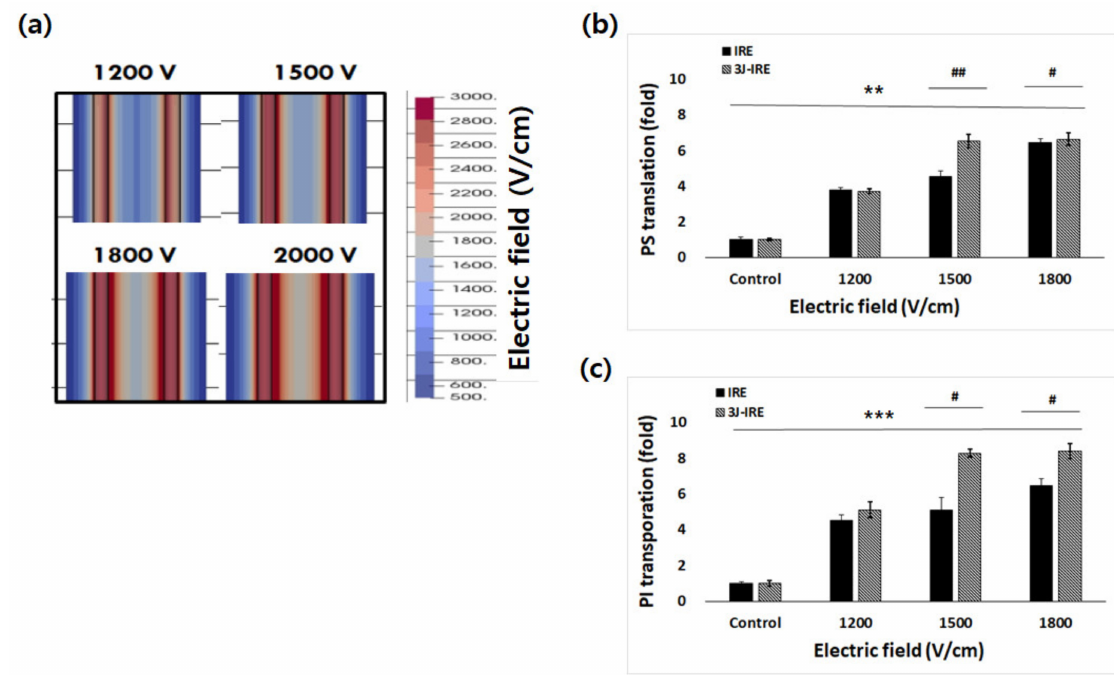
Figure 2. The 3 J/cm 2 NIR pre-treatment enhanced plasma membrane disintegration, right after IRE in HeLa cells. ( a ) Simulations of electric fields between two electrodes. ( b ) Relative MFI of Annexin-V dye according to the electric field intensity w/or w/o NIR pre-treatment. ( c ) Relative MFI of PI dye cells according to electric field intensity w/or w/o NIR pre-treatment. (** p < 0.01, and *** p < 0.001 with the Student’s t -test to the control, # p < 0.05 and ## p < 0.01 with the Student’s t -test to the non-irradiated group ( n =